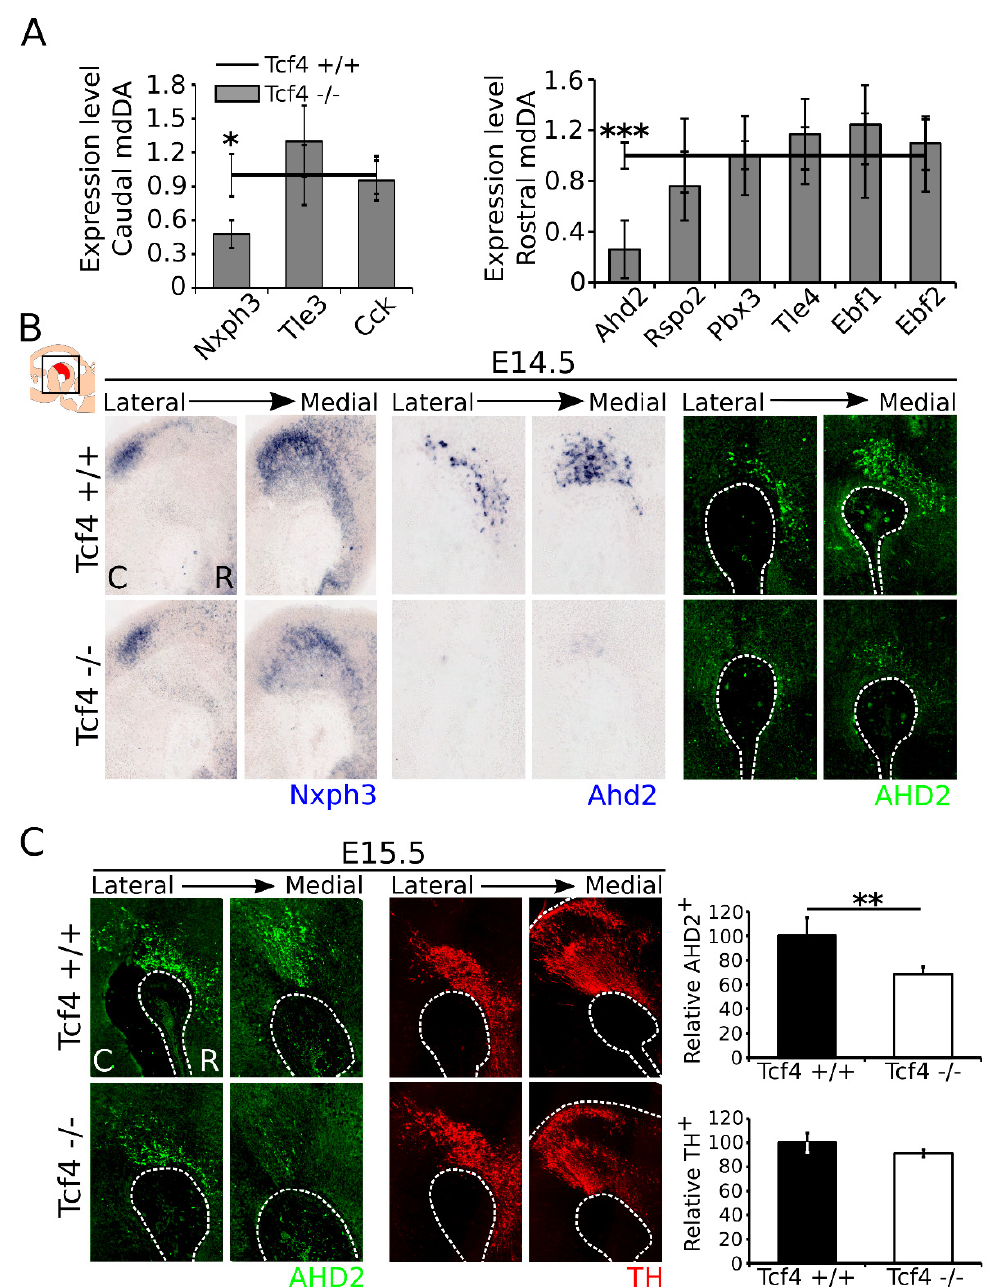
Figure 3. Expression of the caudal marker Nxph3 and the rostral marker Ahd2 is decreased in E14.5 Tcf4 mutant embryos, although expression of AHD2 partly recovers at E15.5. ( A ) qPCR of caudal and rostral markers in the mdDA system. Expression of caudal markers Tle3 and Cck is unaffected in the Tcf4 mutant (n = 4; two-tailed). Expression of Nxph3, on the other hand, shows a significant decrease of ~50% (* n = 4; p = 0.036 two-tailed). Expression of rostral markers Rspo2 , Pbx3 , Tle4 , Ebf1 , and Ebf2 is not altered in the mutant (n = 4; two-tailed). However, expression of the rostral marker Ahd2 is decreased with ~75% in the mutant (*** n = 4; p = 0.0008 two-tailed). WT expression levels were set at 1. ( B ) In situ hybridization of Nxph3 (blue, left panel) and Ahd2 (blue, right panel) confirms the qPCR data and shows that these markers are visibly altered in the midbrain of the Tcf4 mutant compared to WT littermates. AHD2 protein (green) expression is similarly affected in the Tcf4 mutant midbrain at E14.5. C: caudal, R: rostral. ( C ) At E15.5, the expression of AHD2 (green) is partly recovered. Quantification shows an ~30% decrease in the amount of AHD2 + cells at E15.5 (** WT n = 3, mutant n = 4; p = 0.006 two-tailed), although the expression of TH is not visibly altered and the amount of TH + cells is not significantly changed at this stage (black bars) (WT n = 3, mutant n = 4; one-tailed). WT was set at 100%. C: caudal, R: rostral.